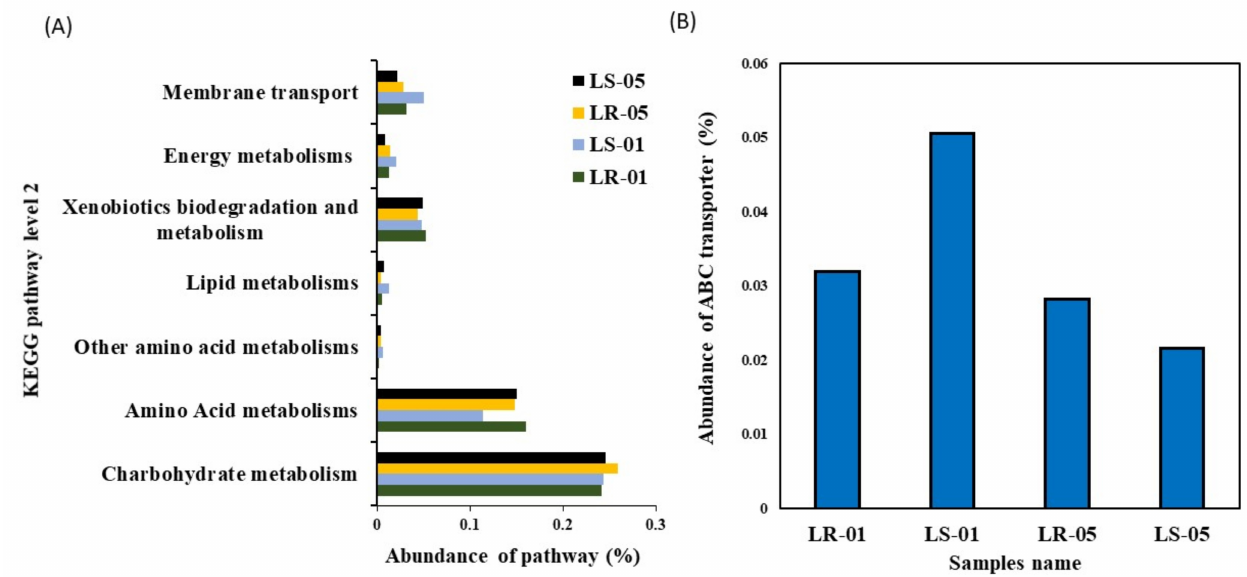
Figure 5. ( A ) Visualization of predicted major metabolic pathway categories relative to the abundance of each sample, including environmental information processing. ( B ) Presence of environmental information processing (ABC transporter) genes in samples collected outside and inside the cave using PICRUSt2